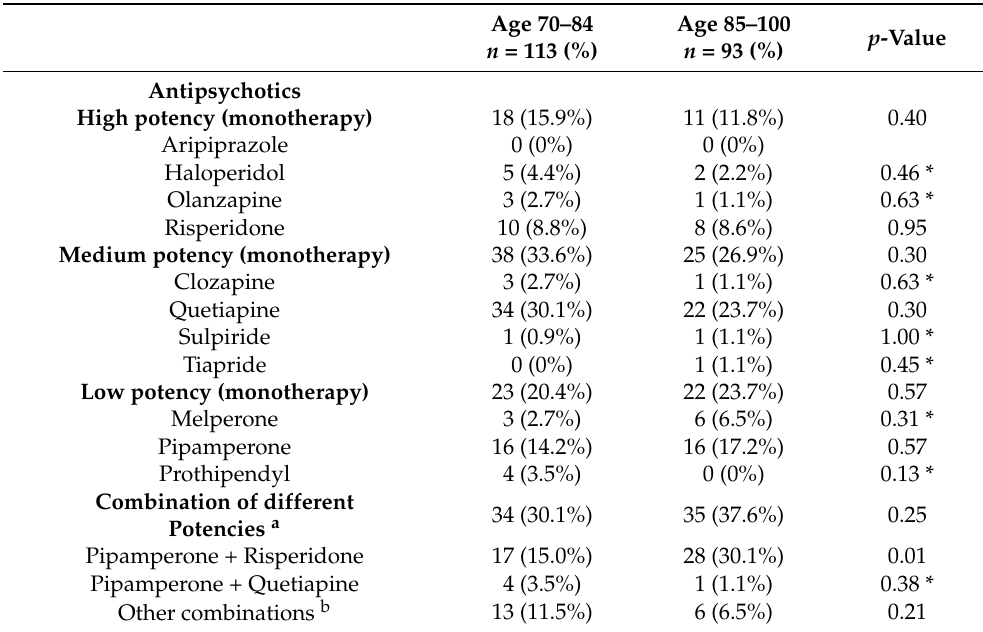
Table 2. The use of antipsychotics in the two age groups classified according to their neuroleptic potency.